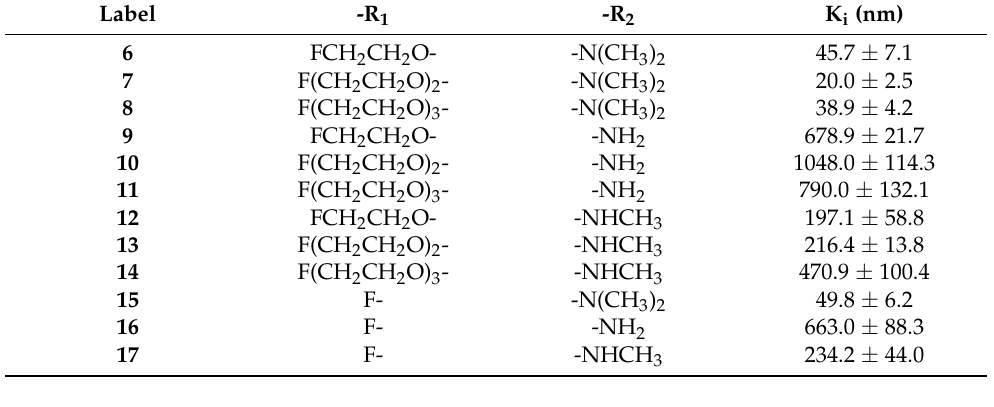
Table 2. Inhibition constants of fluoro- and FPEG-chalcone derivatives against 4-[125I]iodo-4 (cid:48) - dimethyamino-calchone ([ 125 I] 3 ) as adapted from [20].